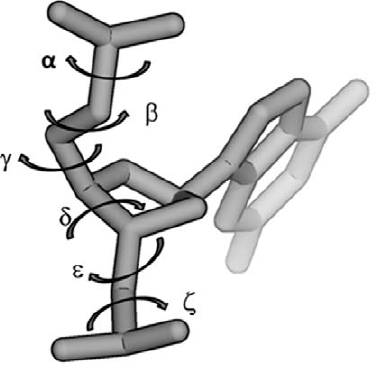
Figure 1. Schematics of torsional angles in a nucleotide phosphate backbone. a and c angles determine canonical/non- canonical backbone conformations; e and f define BI and BII sub-states of